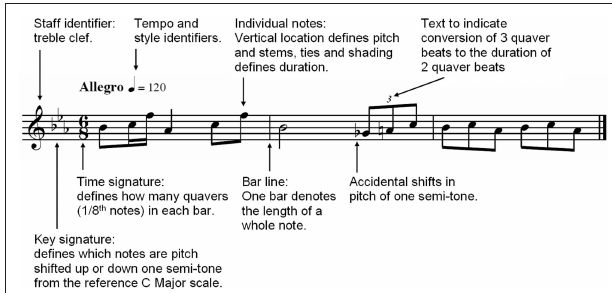
Figure 1 | An example of western music notation.